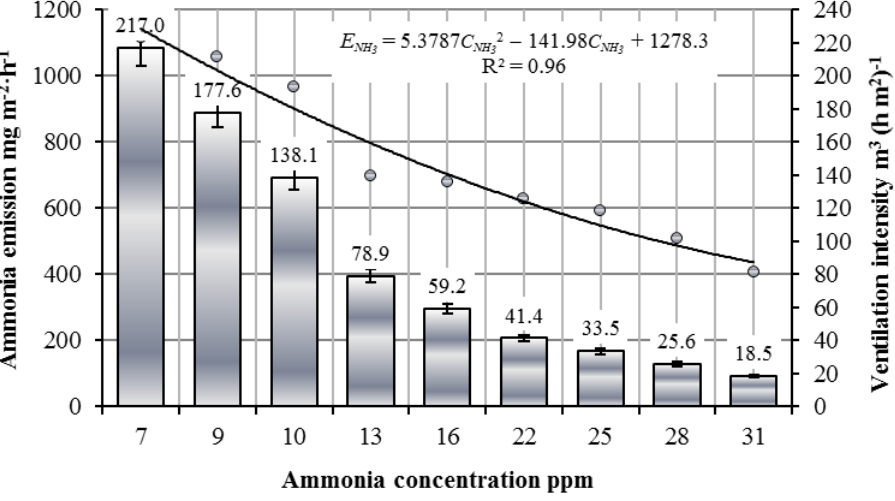
Figure 9. Dependence of ammonia emission (line) from the liquid cattle manure on ammonia concentration at different ventilation intensities (column).